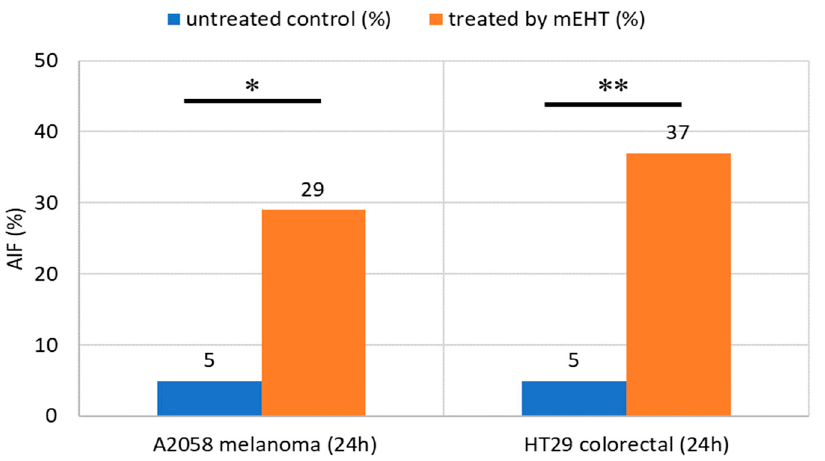
Figure 17. The enrichment of NK cells after 24 h of mEHT treatment in xenograft models for human melanoma and colorectal tumors [116]. * p < 0.05, ** p < 0.01. Table 1. NK cell activity and mEHT (** means p < 0.001 and *** means p < 0.0005).